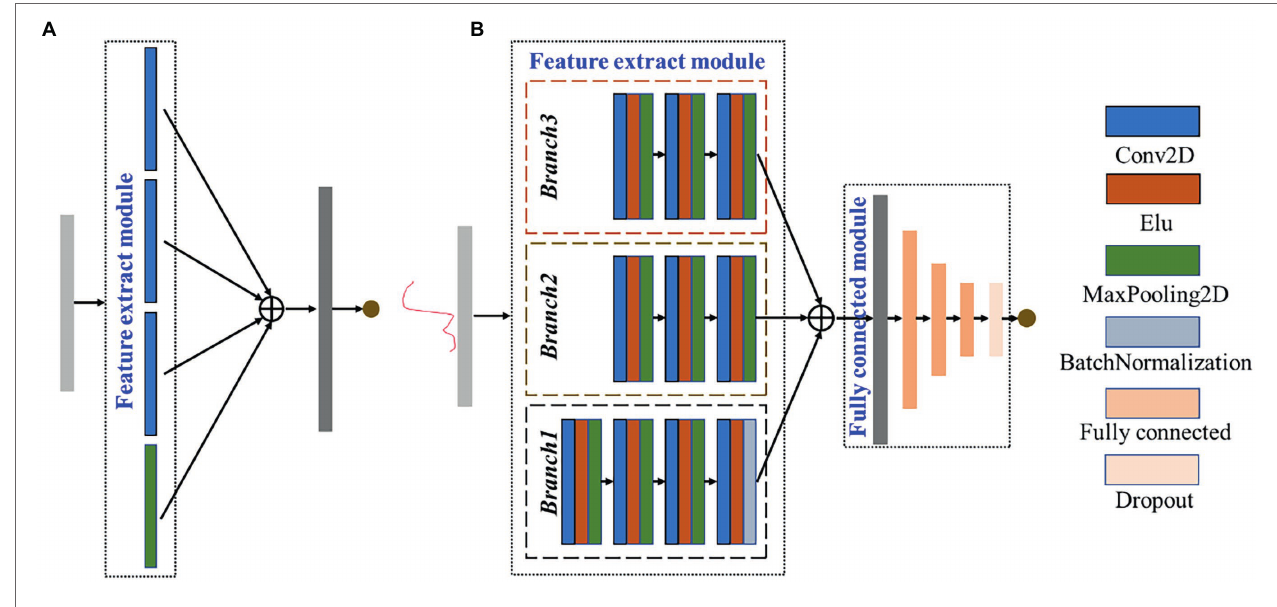
FIGURE 3 | Architecture of the naïve version Inception module (A) and Deep2D (B) .